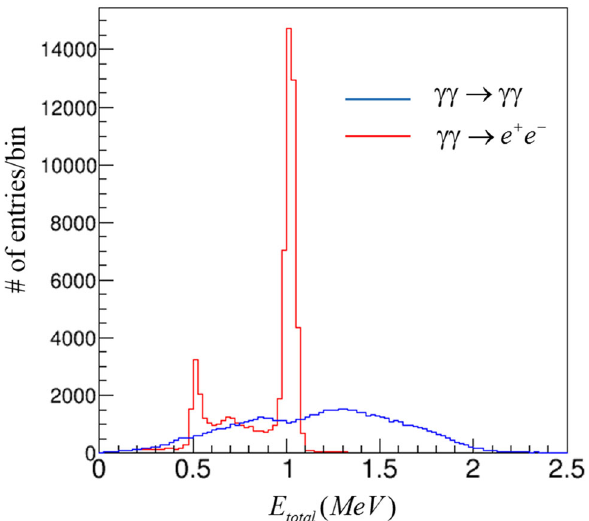
Fig. 5 Total energy deposition observed by the detector. Clear peaks caused by a positron annihilation in the materials for γγ → e + e − pro- cessareobserved;thepeakaround1MeVrepresentsthecasewheretwo 0.511 MeV photons are destructed, while the peak around 0.511 MeV is indicative of the case in which one of the two photon escapes from the detector